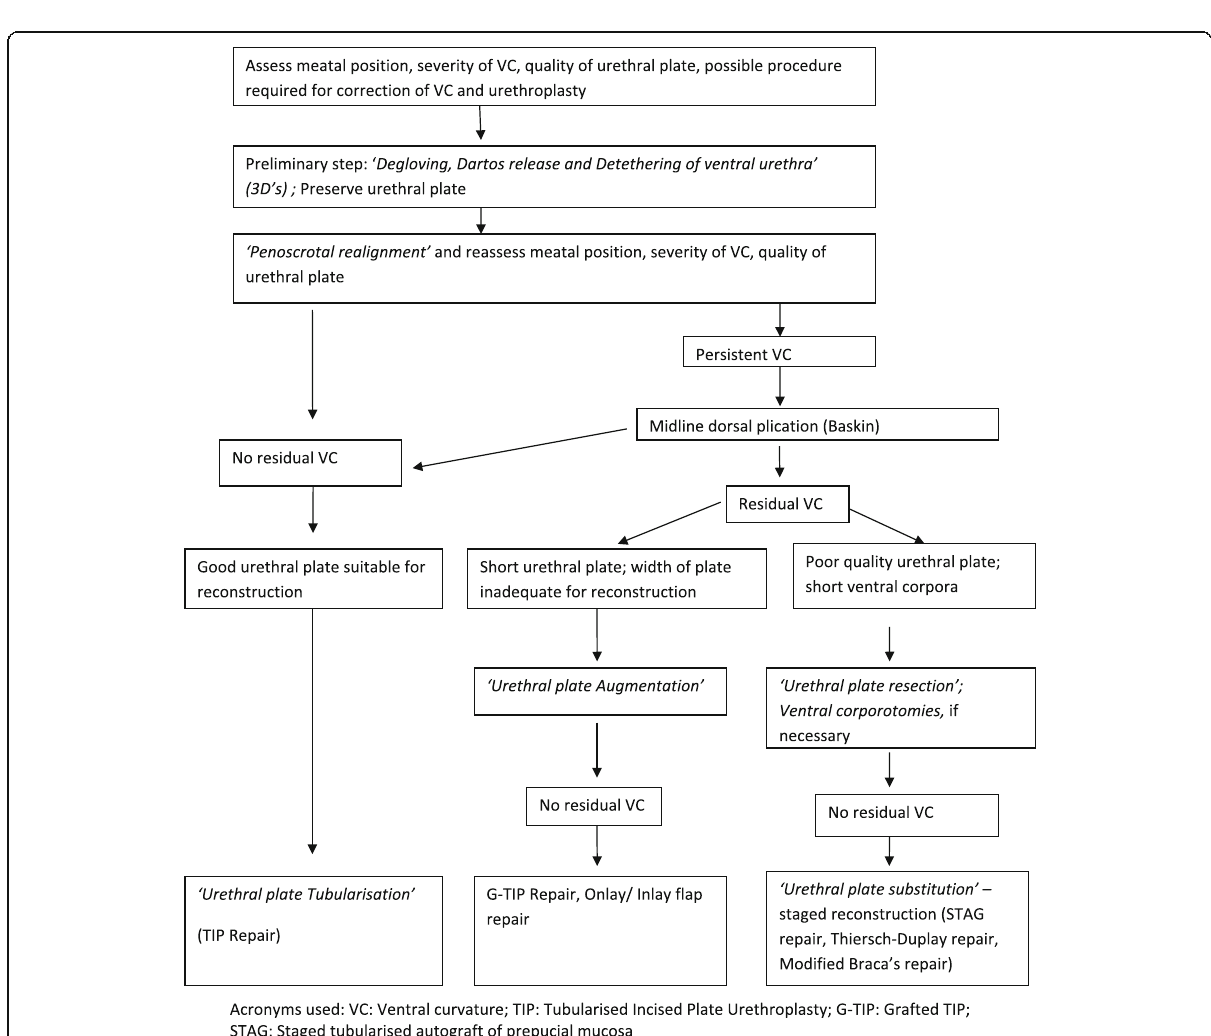
Fig. 1 Algorithm followed for proximal/mid-penile hypospadias repair in the present series. VC ventral curvature, TIP tubularized incised plate urethroplasty, G-TIP grafted TIP, STAG staged tubularized autograft of prepucial